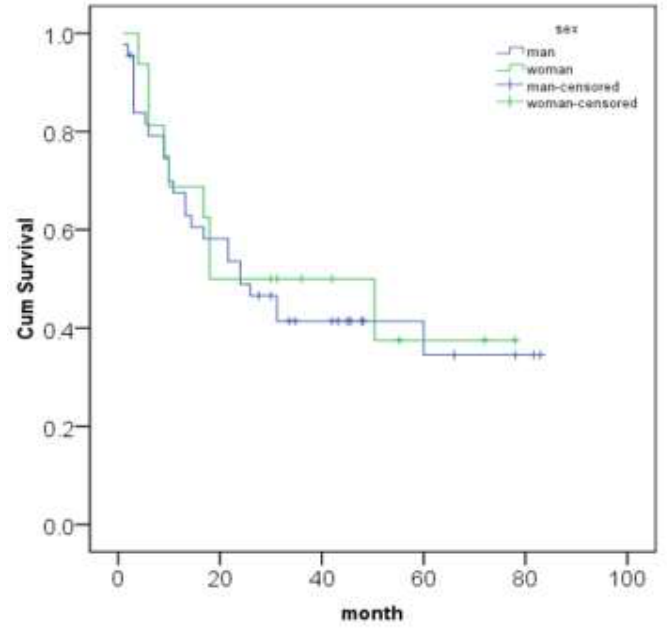
Figure 2 : The average survival of patients with GC. Average survival for men and women was 40.23±5.32 and 41.03±8.14 months, respectively (P= 0.744) (Figure 3) Also, the one, two, three, four, and five years’ survival of investigated patients were 0.68, 0.49, 0.43, 0.39, and 0.34 years, respectively. Also, it has been reported in another study that the one, three, and five year’s survival of GC patients was 0.66, 0.19, and 0.06% that was lower than the result of the current study. This enhancement in the survival of patients in our study can be due to improvements in surgical and treatment methods in recent years compared to the study time of before researches (12).